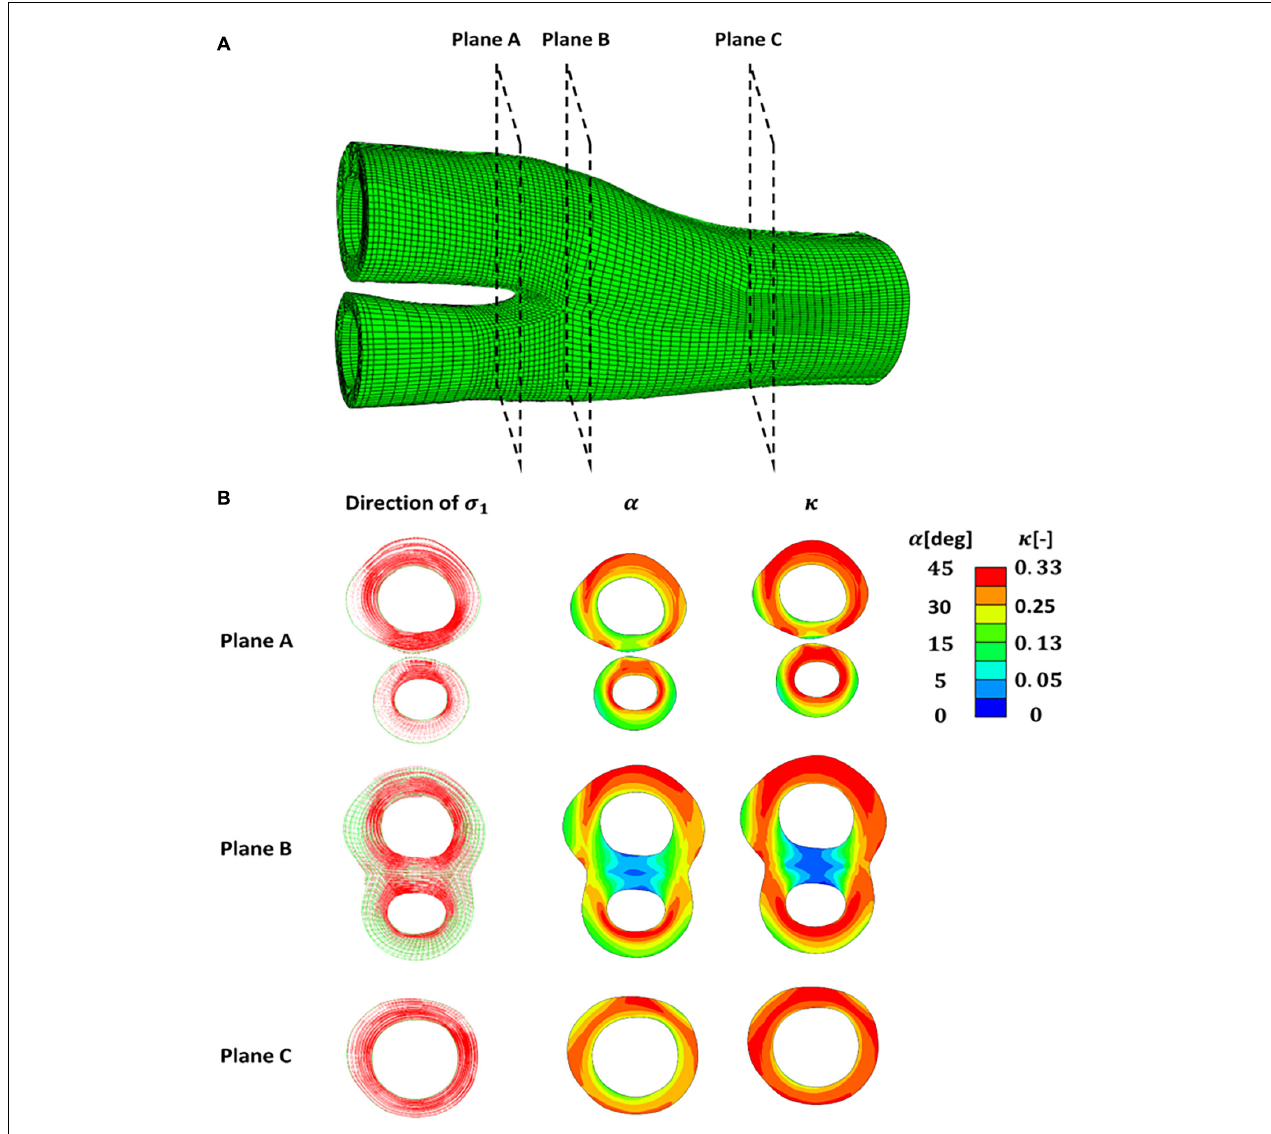
FIGURE 7 | (A) A healthy carotid bifurcation cross sectioned using planes (A–C) . (B) Presentation of the directions of the maximum and intermediate principal stresses in each cross section along with the angle and dispersion of fibres. The angle of fibres ( α ) is presented with respect to the direction of the maximum principal